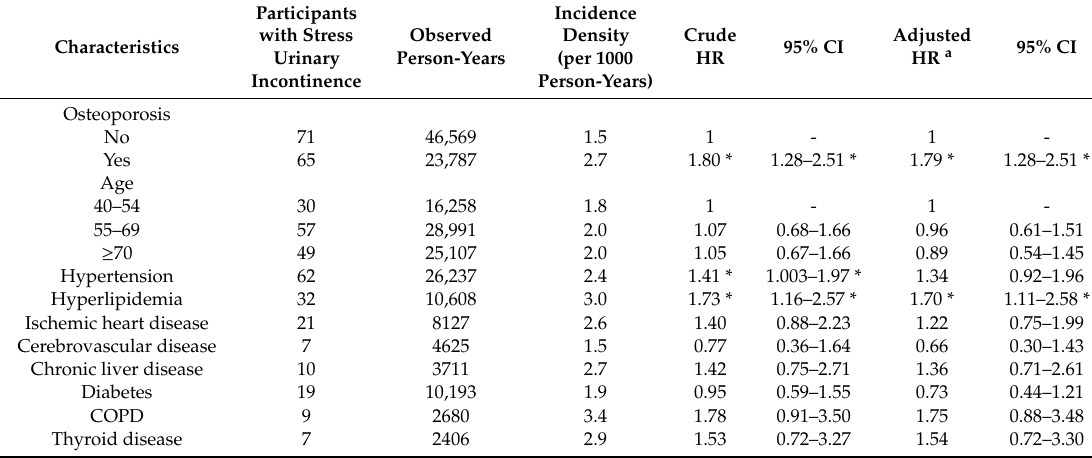
Table 2. Cox proportional hazard model of osteoporosis and risk of urinary incontinence through comorbidity stratification.